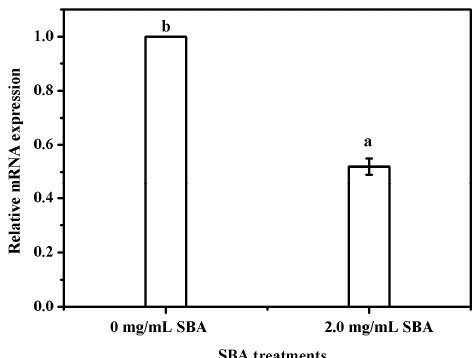
Figure 4. SBA lowered the mRNA expression of Bcl-2 in IPEC-J2. The cells were incubated with 0 or 2.0 mg/mL SBA for 24 h, the effects of SBA on mRNA expression of Bcl-2 were analyzed using qRT-PCR. Means with different superscript are significantly different in compare with its control. Each column is depicted as a mean ± SEM of three independent experiments.